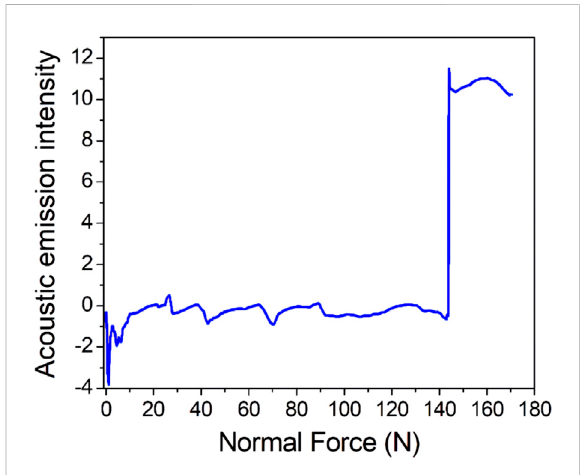
FIGURE 6 Acoustic emission spectrum for the coating (the initial load was 0 N, the fi nal load was 150 N, the scratch speed was 2 mm/ min, the loading rate was 50 N/min and n = 3).